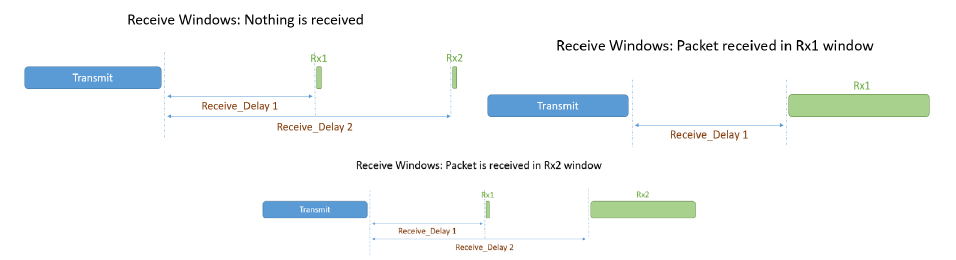
behavior was calculated, and both the devices and the network were designed to cope with it. In particular, 51 gateways were installed on the site (including tunnels and LHC